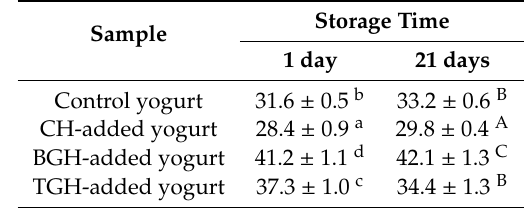
Table 3. The measured syneresis extents (%) of the four yogurt samples stored at 4 ◦ C for 1 and 21